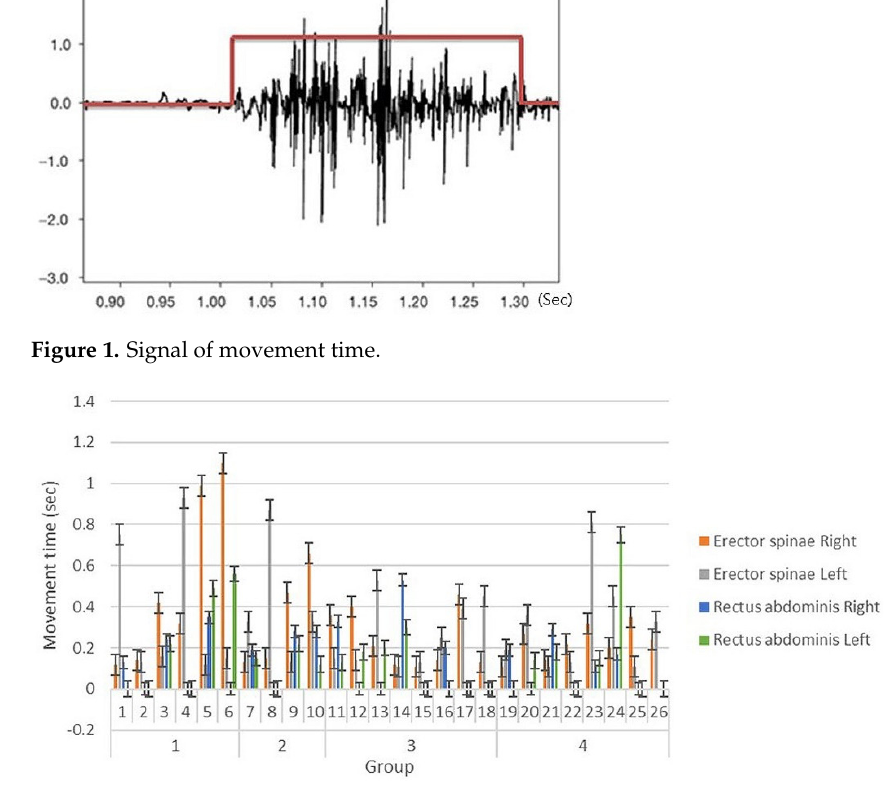
Figure 2. Movement time.